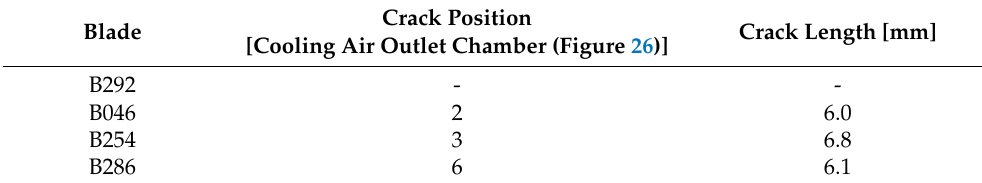
Table 7. Overview—turbine blades.